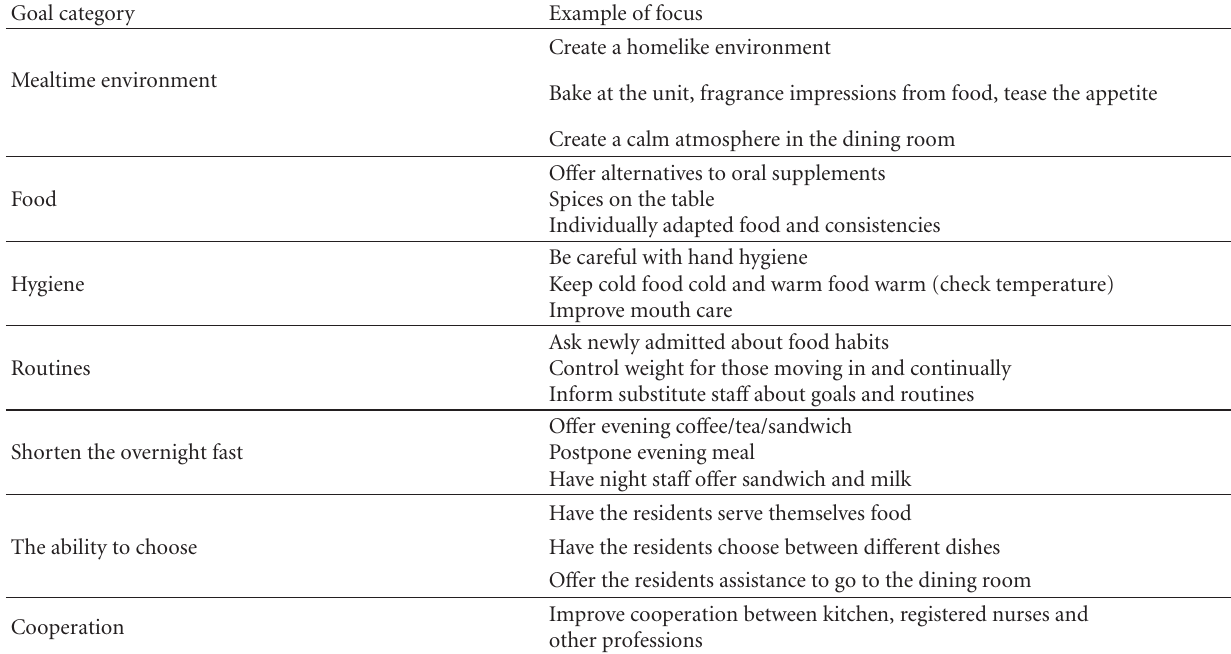
Table 4: Knowledge-to-action goals set within study circles focusing on eating and